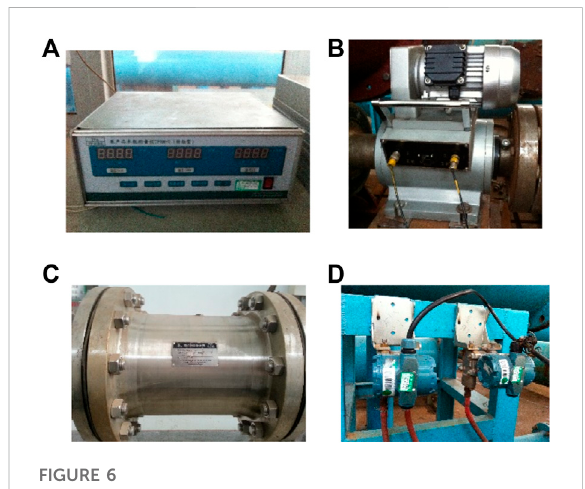
FIGURE 6 Measuring instruments: (A) data collector, (B) torque speed sensor, (C) fl owmeter and (D) pressure sensor.